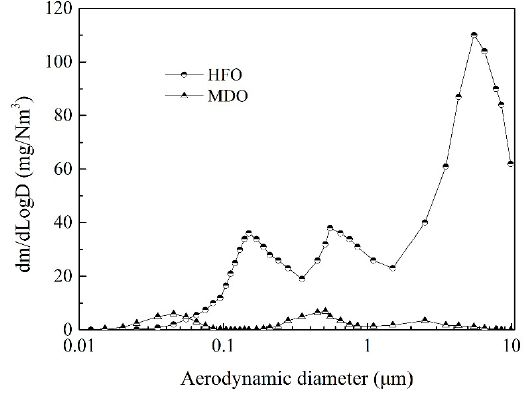
Figure 4. Particle mass size distribution in the exhaust gas from the engine.